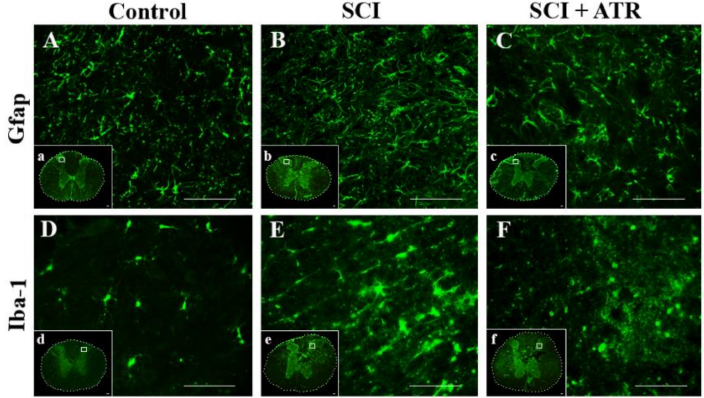
Figure 3. Representative images showing the activation of astrocytes and the microglia in the spinal cord after the Th9 compression and the atorvastatin treatment. Immunostaining of the astrocytes and microglial cells at the Th9 level of intact animals ( A , D ). Increased expression of the astrocytes ( B ) and the microglia ( E ) 24 h after the injury at the lesion site. The administration of ATR (5 mg/kg; i.p., immediately after the SCI) reduced the density of the activated astrocytes ( C ) and decreased the massive activation of the microglial cells ( F ). Scale bars: ( A – F —100 µ m; a – f —1000 µ m). Atorvastatin—ATR; GFAP—astrocytes; Iba-1—microglia; SCI—spinal cord